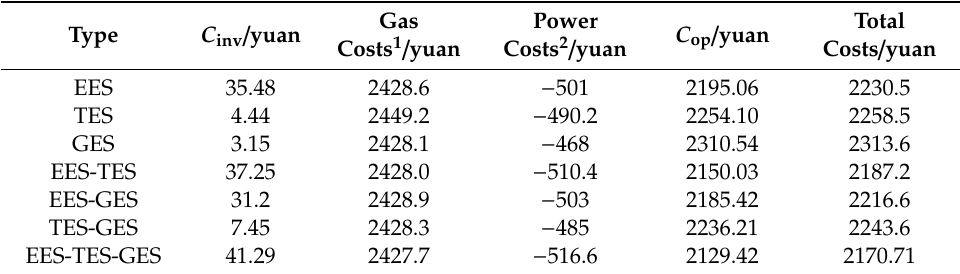
Table 6. The costs of the RIES in di ff erent types under the grid-connected mode.